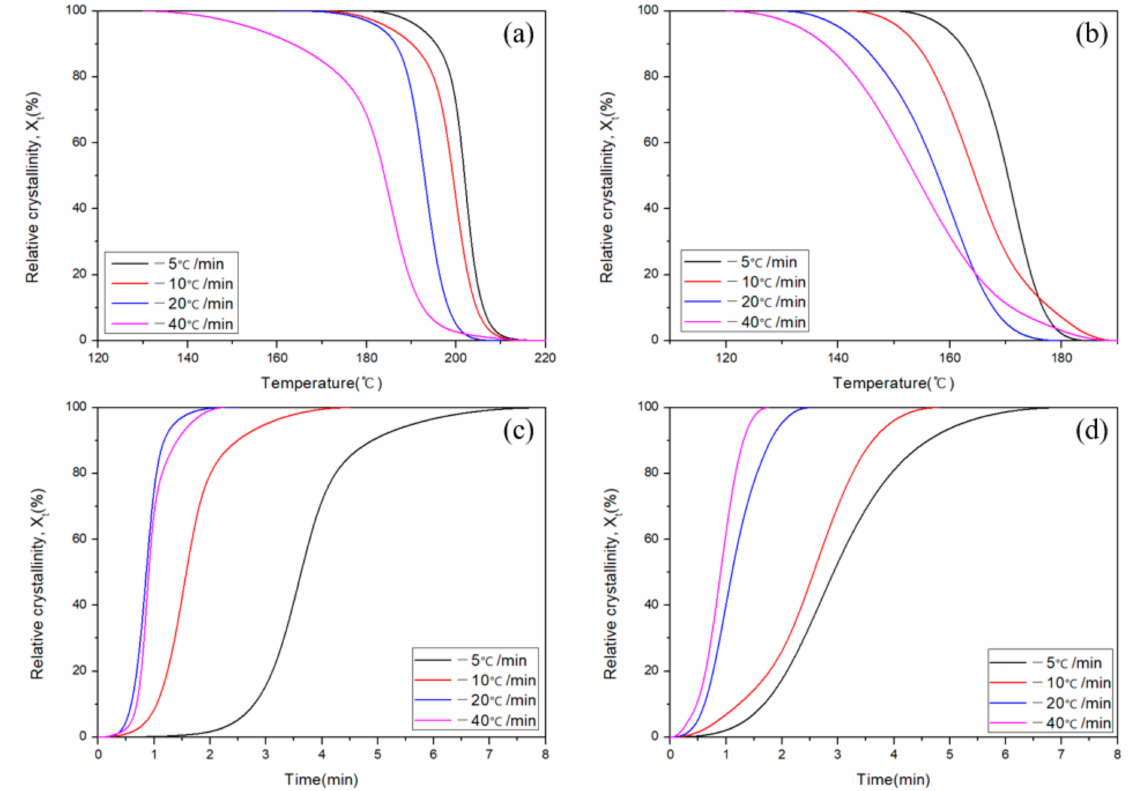
Figure 6. Relative crystallinity as a function of different cooling rates; ( a ) APA crystallinity over temperature, ( b ) Car- bon/APA composite crystallinity over temperature, ( c ) APA crystallinity over time, and ( d ) Carbon/APA composite crystallinity over